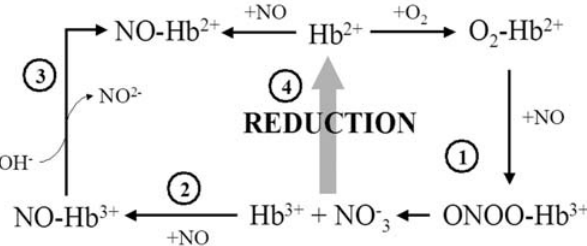
Figure 1. NO reactions with hemoglobins. 1, NO dioxygenase activity; 2, NO binding to the ferric Hbs; 3, NO-induced heme iron reduction; 4, O 2 nitroxylase activity; 5, reduction reaction of ferric Hbs (4).